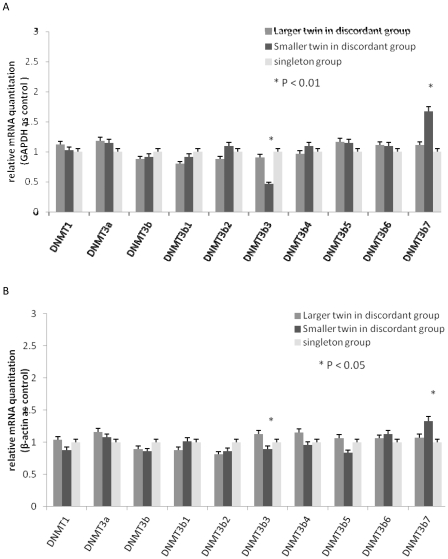
DNMTs transcript levels among discordant twins and singleton group.The values shown indicated the relative quantitation of the DNMT mRNAs, which were standardized to GAPDH (A) and β-actin (B), normalized to the singleton control group. The DNMT 3b3 mRNA decreased and DNMT 3b7 mRNA increased in smaller discordant twin group compared with the larger discordant twin group and singleton group.